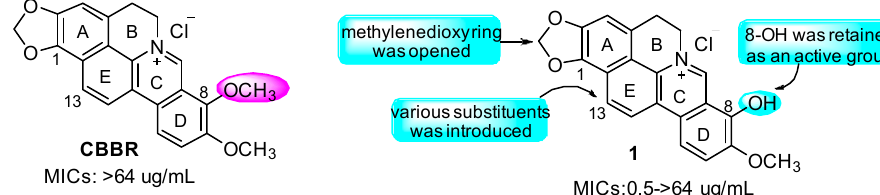
Figure 1. Structures of CBBR and 1 as well as modification strategies.